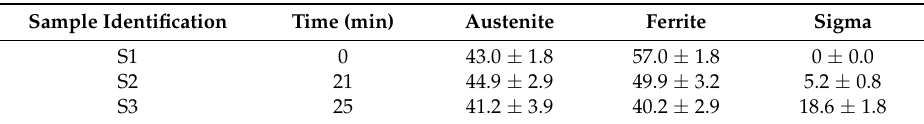
Table 2. Percentage of austenite, ferrite and sigma phases (vol %) as received (S1) and after thermal treatment at a different interval of time (S2 and S3, respectively).